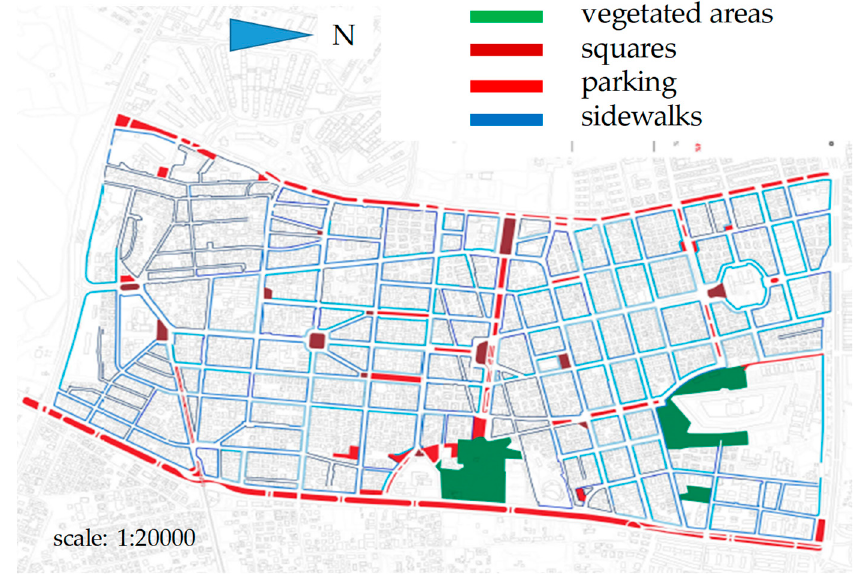
Figure 3. Designated use of urban surfaces shown in Figure 1.